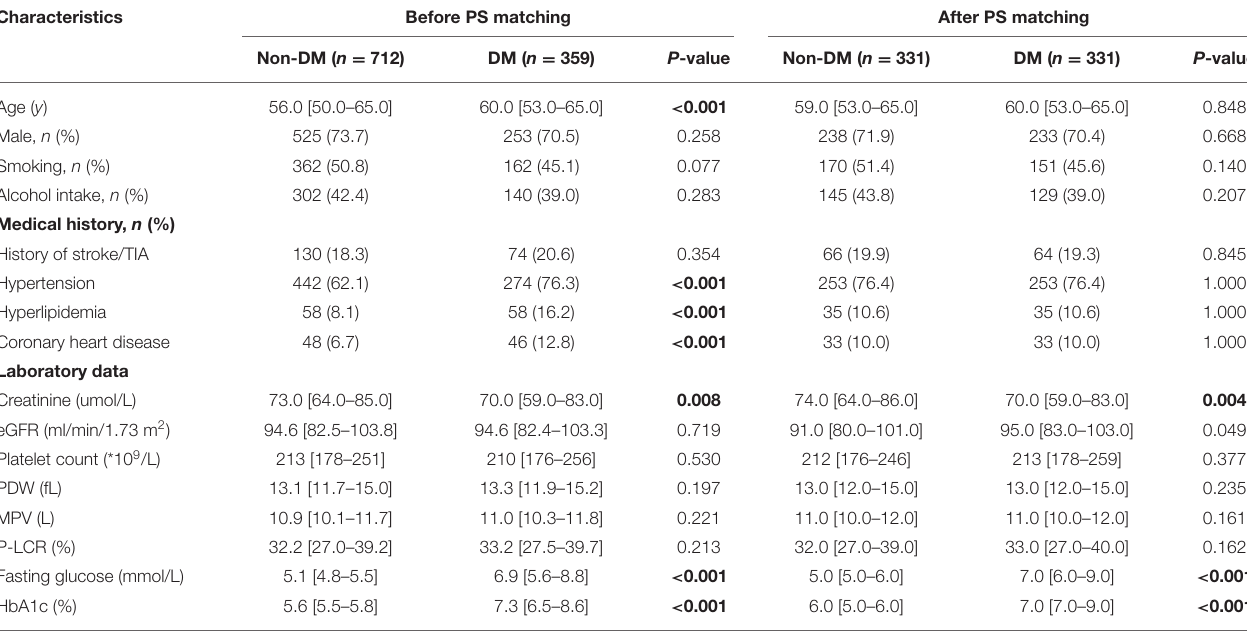
TABLE 1 | Patients’ baseline characteristics before and after PS matching. Characteristics